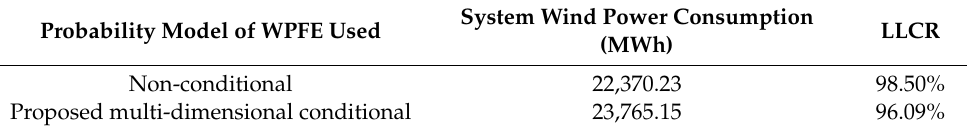
Figure 11. Experimental comparison of the SED problem: ( a ) using the non-conditional probability model of WPFE without considering the multi-dimensional conditional information; ( b ) using the proposed multi-dimensional conditional probability models of WPFE. Table 4. Results of the proposed SED problem.